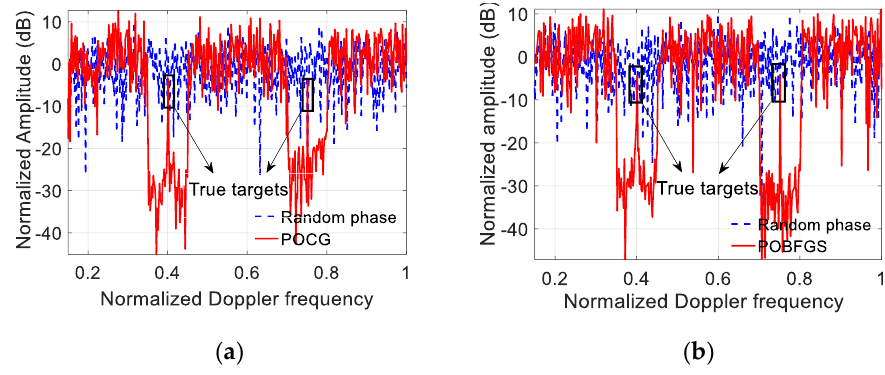
Figure 4. The countermeasure effect in the presence of the VDJ.